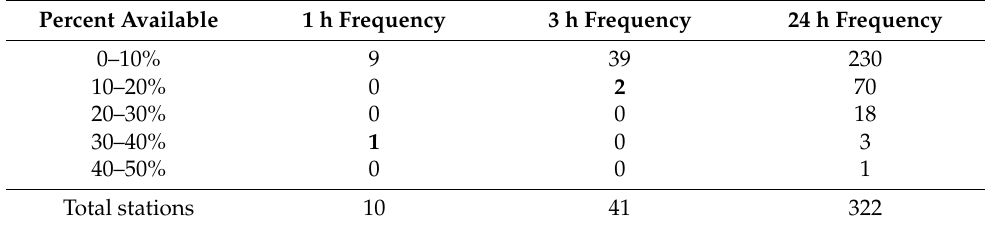
Table 1. Number of HCHO ground monitoring stations in the United States, with data distributed by the EPA AQS. Stations are grouped based on data availability, and by measurement frequency (hourly, 3 h, and 24 h). Data availability is calculated as the percentage of measurements available from 2006 to 2015 relative to the potential number of measurements during this period at the monitor’s reporting frequency. The three sites used for analysis of the diurnal HCHO cycle are marked in bold, which include the 1 h site with 30–40% data availability (St. Louis, MO, USA), and the two 3 h site with 10–20% data availability (Burbank, CA, USA; Pico Rivera, CA, USA). These three sites are marked as triangle in Figure